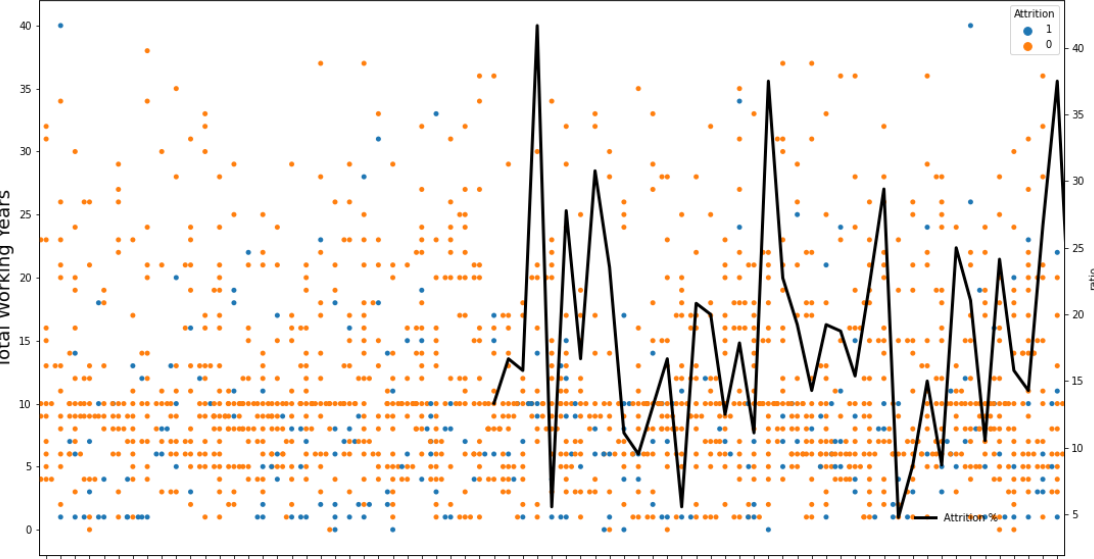
Figure 3. The hourly rate and total working years data distribution analysis by employee attrition.